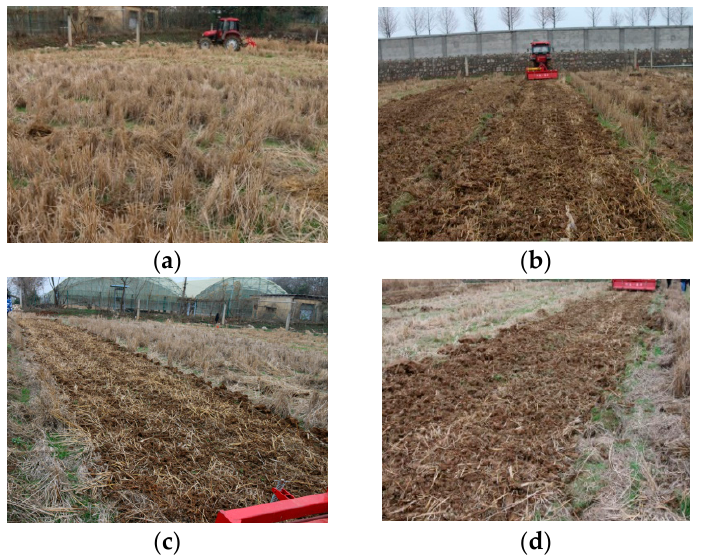
9 of 14 Figure 3. The simulation process of CTSR. 3. Results 3.1. Performance Indicators in the Field Experiment The tillage processes of RT, CTSR, and CTDR were shown in Figure 4 and the perfor- mance indicators of RT, CTSR, and CTDR in the rice field experiment was given in Table 3. The ratio of straw coverage was an important performance indicator for straw incorpo- ration tillage implement. The ratio of straw coverage of CTSR and CTDR was 89.84% and 90.53%, respectively, and increased obviously compared with that of RT, which was 68.95%. The stability coefficient of tillage depth of combined tillage implement was also higher than that of sole rotary tiller. It was observed that stability coefficient of tillage depth raised from 84.66% for RT to 88.50% for CTSR and 93.8% for CTDR. The perfor- mance of CTDR on the stability coefficient of tillage depth was better than CTSR. The value of CV of the surface evenness after tillage for CTSR and CTDR was approached to nearly 20 mm from 24.6 mm that obtained from RT. Compared with RT, CTSR, and CTDR